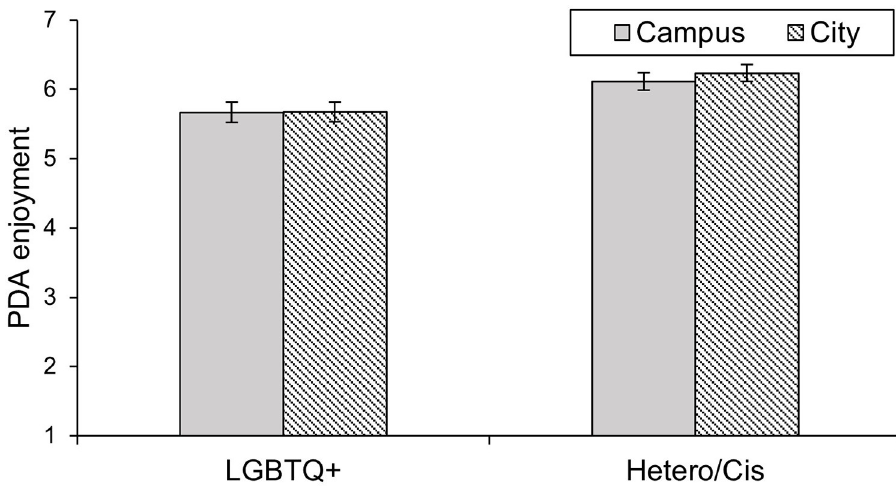
Fig 4. Reported enjoyment of PDA by LGBTQ � and Hetero/Cis participants in the contexts of a campus and a city in Study 2. Error bars represent +/– 1 SEM .